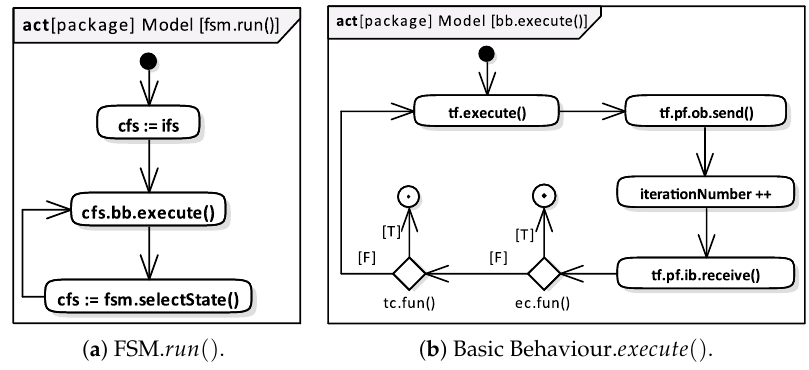
Figure 5. FSM and Basic Behaviour